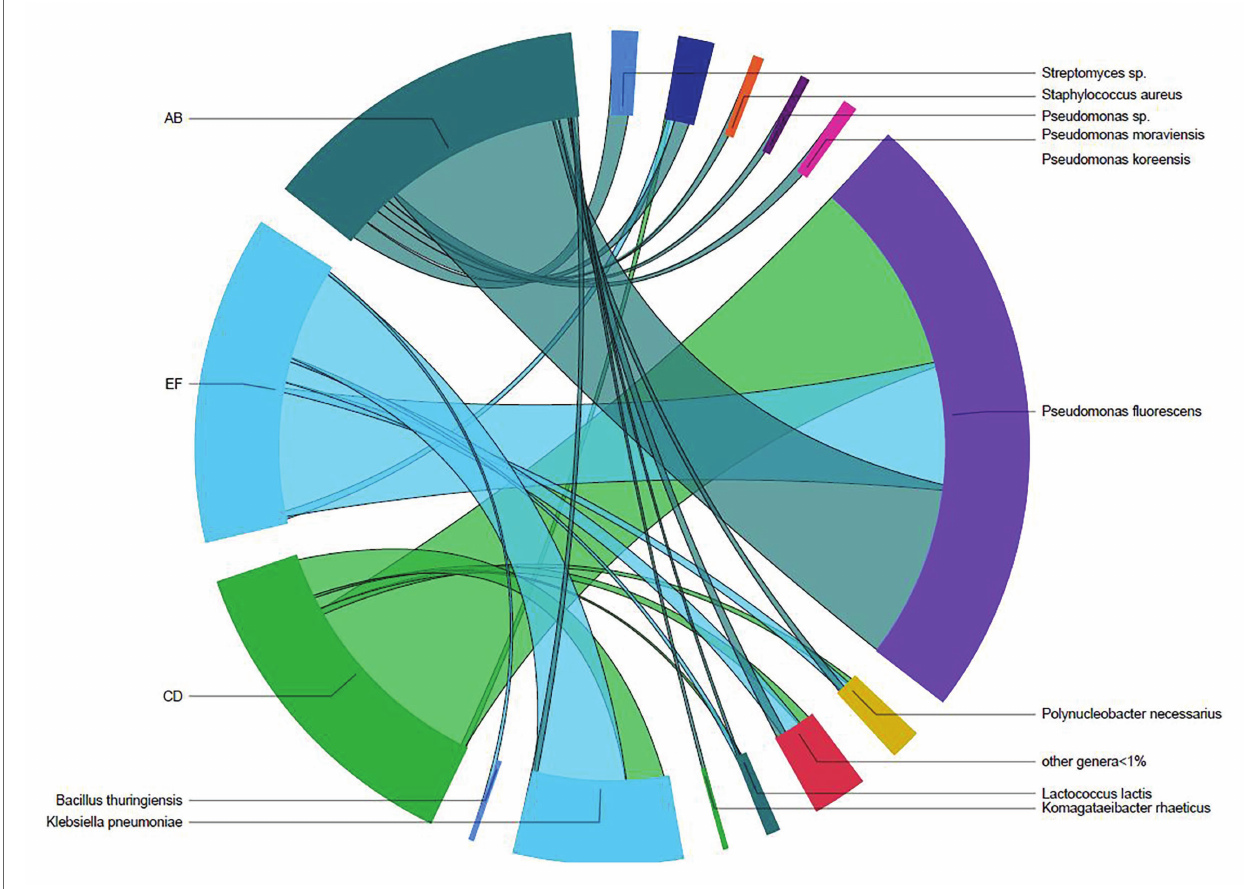
FIGURE 2 | Shared taxa between the three batches of unpasteurized milk (AB, CD, and EF) used to manufacture Gouda